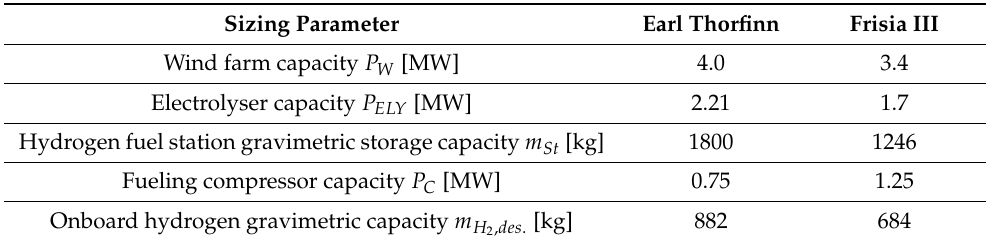
Table 4. Partial results of hydrogen fuel system component sizing for the Earl Thorfinn and Frisia III. Sizing